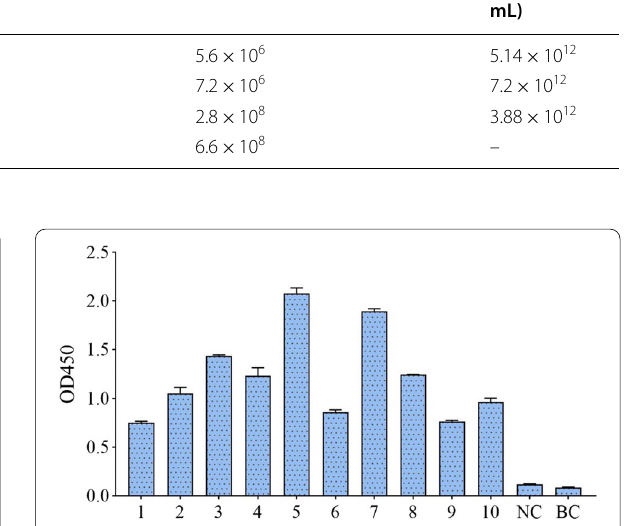
Table 2 Library sizes and phage titers of each bio-panning Round Coating concentration (per well)